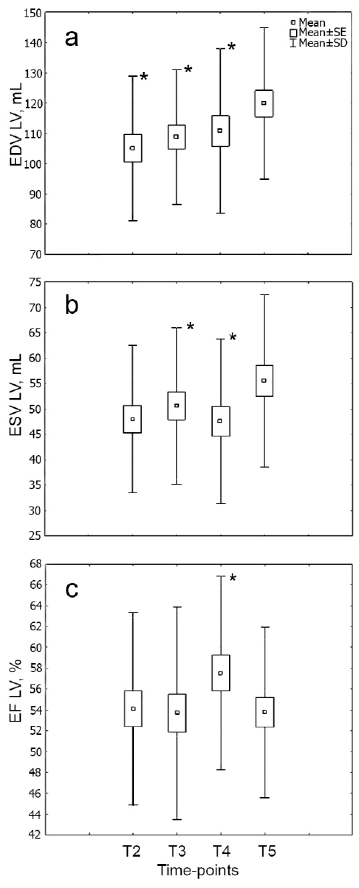
Figure 1. Dynamics of the main echocardiographic parameters (( a ) EDV, ( b ) ESV, ( c ) EF) of LV in the six-month period in patients with STEMI ( n = 31). Note: * p < 0.05: significant difference between the time point T5 and other time points. EDV—end-diastolic volume, ESV—end-systolic volume, LV—left ventricle, EF—ejection fraction; T2—3rd day; T3—7th day; T4—14th day; T5—6months after MI [4].